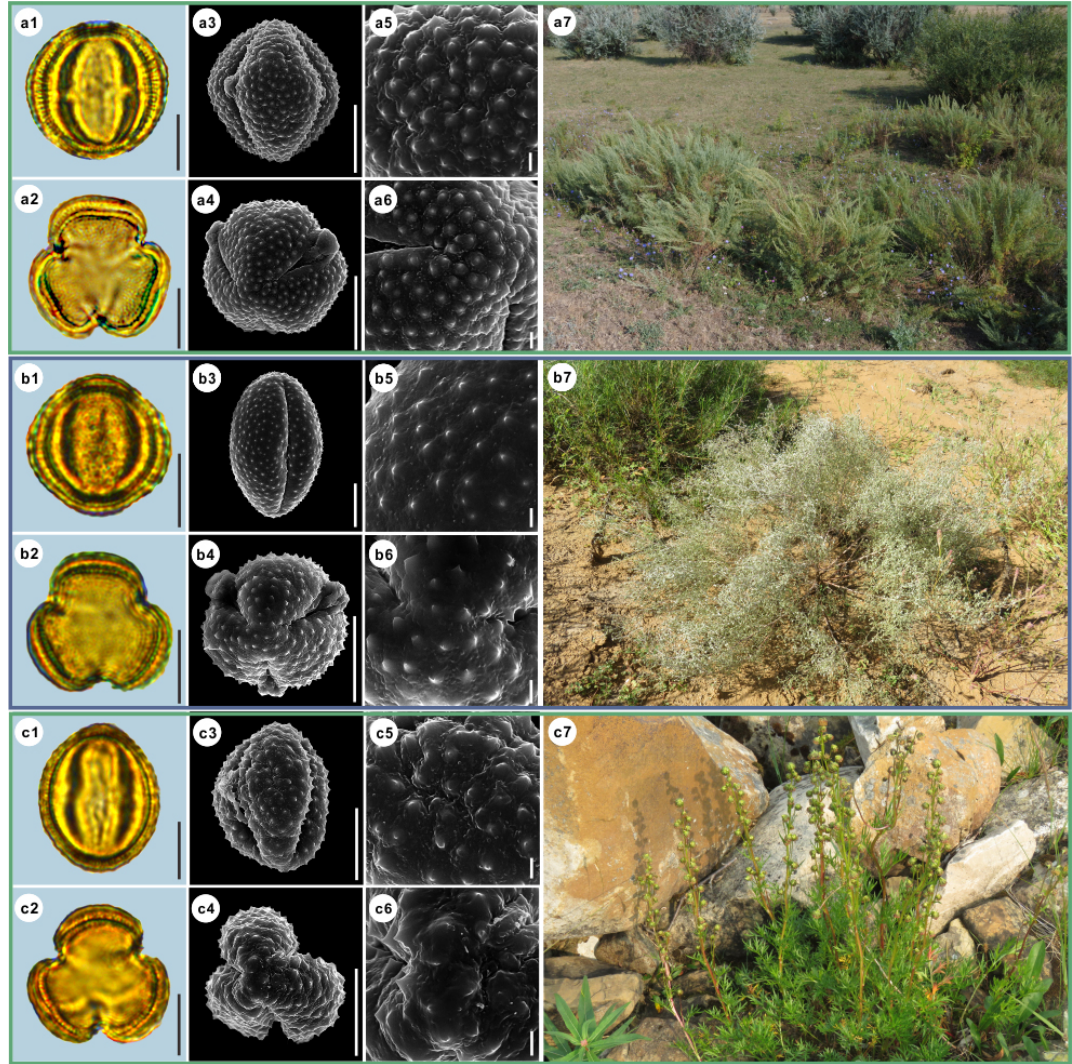
Figure 11. Pollen grains and the habitats of their source plants. (a) Artemisia abrotanum ; (b) Artemisia blepharolepis ; and (c) Artemisia norvegica . Pollen grains in equatorial view under LM (a1, b1, c1) and SEM (a3, a5, b3, b5, c3, c5) , in polar view under LM (a2, b2, c2) and SEM (a4, a6, b4, b6, c4, c6) , along with the habitats of their source plants (a7 cited from https://www.inaturalist.org/photos/116106722, last access: 19 August 2022, by © , b7 provided by © Ji-Ye Zheng, c7 cited from https://www.inaturalist.org/photos/ 161393521, last access: 19 August 2022, by © Erin Springinotic ) . Scale bar in LM and SEM overview 10µm, and in SEM close-up